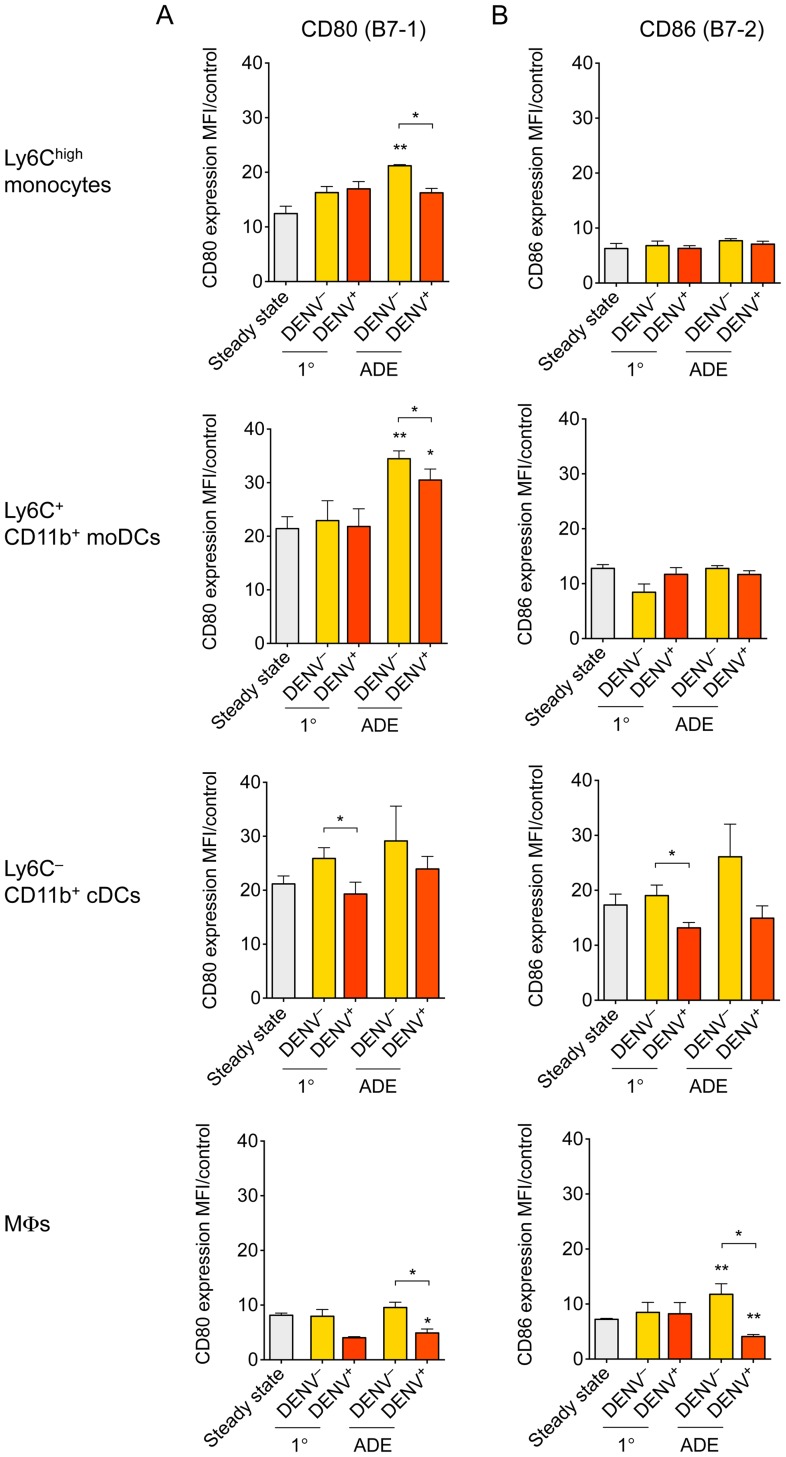
Expression of activation markers on Ly6Chigh monocytes, moDCs, cDCs and MΦs.
Ifnar
–/– mice were inoculated i.d. with DENV2 during 1° or ADE infection. (A and B) Bar graphs show mean ±SEM of CD80 (B7-1) (A) or CD86 (B7-2) (B) surface protein expression determined via flow cytometric analysis and calculated as median fluorescence intensities (MFI) of specific stains divided by the MFI of isotype-matched control stains. CD80 and CD86 expression was examined on Ly6Chigh monocytes, Ly6C+ CD11b+ moDCs, Ly6C– CD11b+ cDCs, and MΦs during steady state, or 48 hpi with DENV under 1° or ADE conditions. In DENV-inoculated samples, each cell population was gated further on the presence of intracellular DENV proteins NS3 and E for DENV-infected cells (DENV+) or the absence of DENV proteins for non-infected bystander cells (DENV–). Significant differences in activation marker expression after i.d. inoculation with DENV compared to steady state are marked as * for p≤0.05 and ** for p≤0.01 above individual bars. Significant differences between DENV– and DENV+ within the same sample are marked between bars with brackets and were calculated using the paired t-test. Pooled data from two independent experiments (n = 6 per condition).